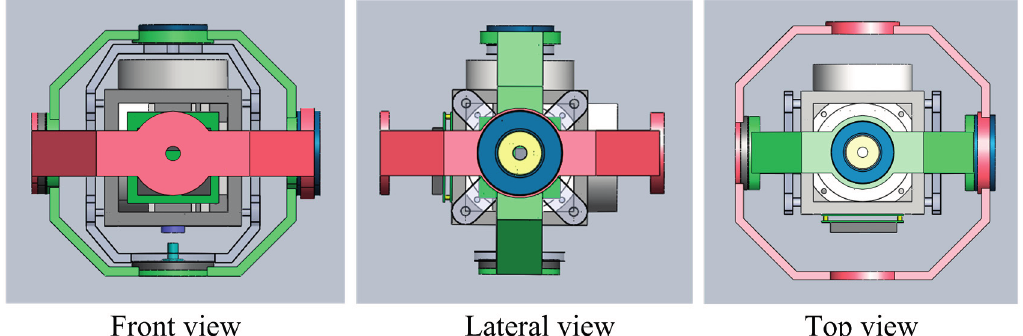
Figure 2. The three views of the